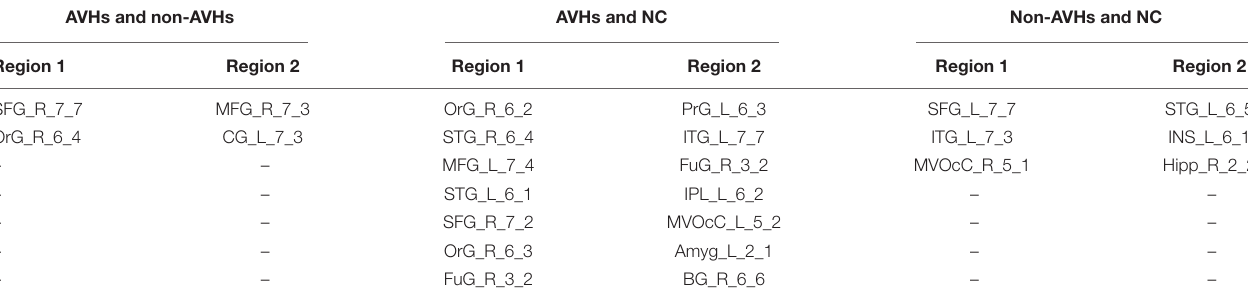
TABLE 4 | Significant differences in variances of the dynamic functional connectivity matrices obtained without regressing out global signal (overlap = 0.6). AVHs and non-AVHs AVHs and NC Region 1 Region 2 Region 1